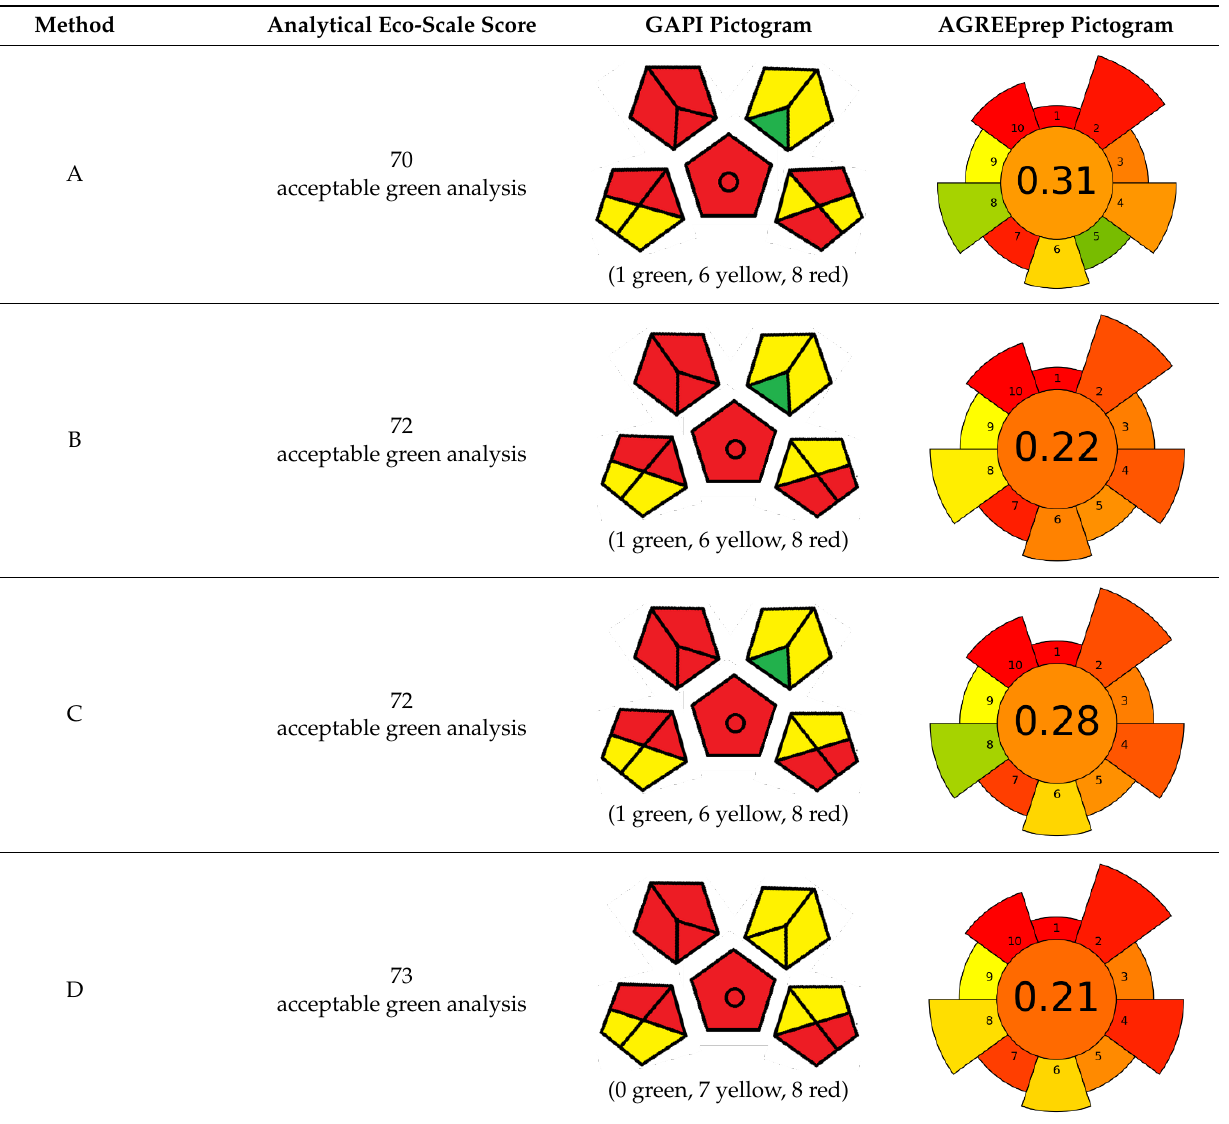
Table 3. The greenness profile of the employed (A –G’) methods for analysis FAMEs in milk sample using Eco-Scale, GAPI, and AGREEprep metrics.